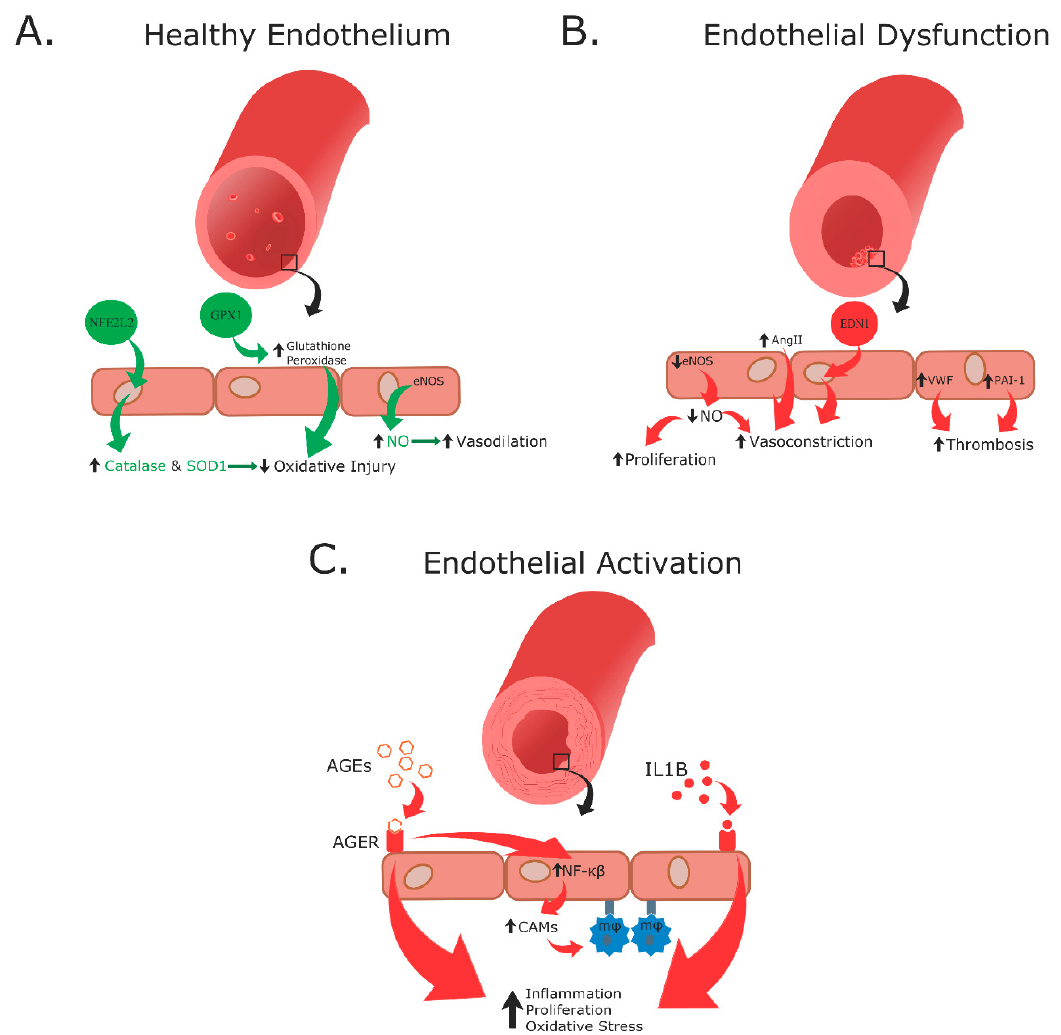
Figure 4. Effects of hyperglycemia leading to endothelial damage. Healthy endothelium ( A ) has signaling through